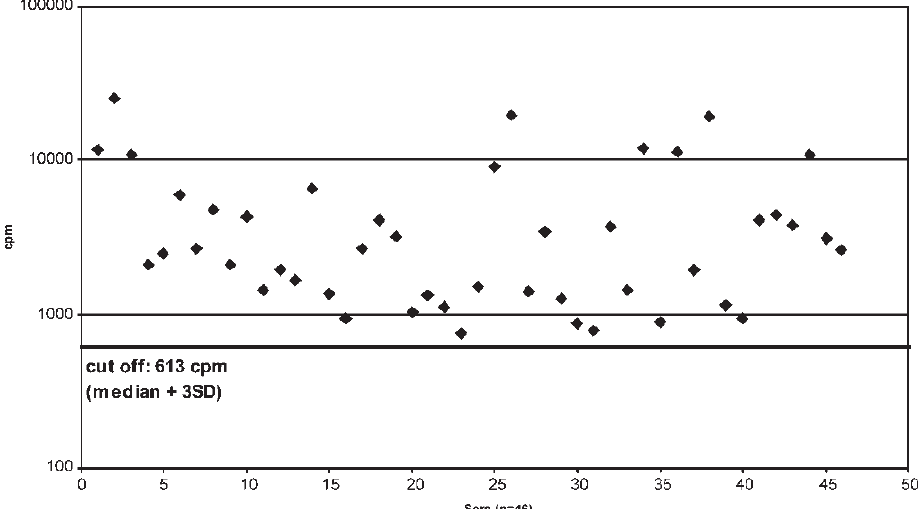
FIGURE 4 Immunoreactivity of BCKADC-E2 positive sera against C-terminal sequences of the human branched chain